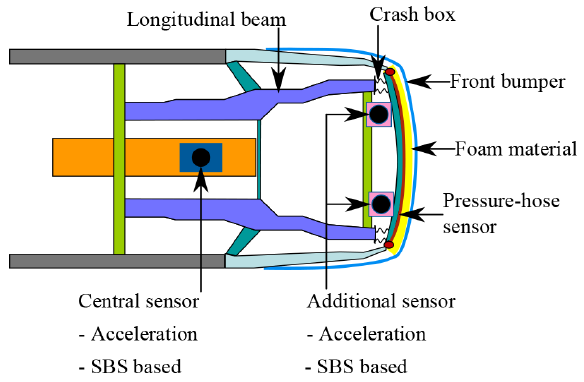
Figure 1. Different crash sensors used to detect frontal